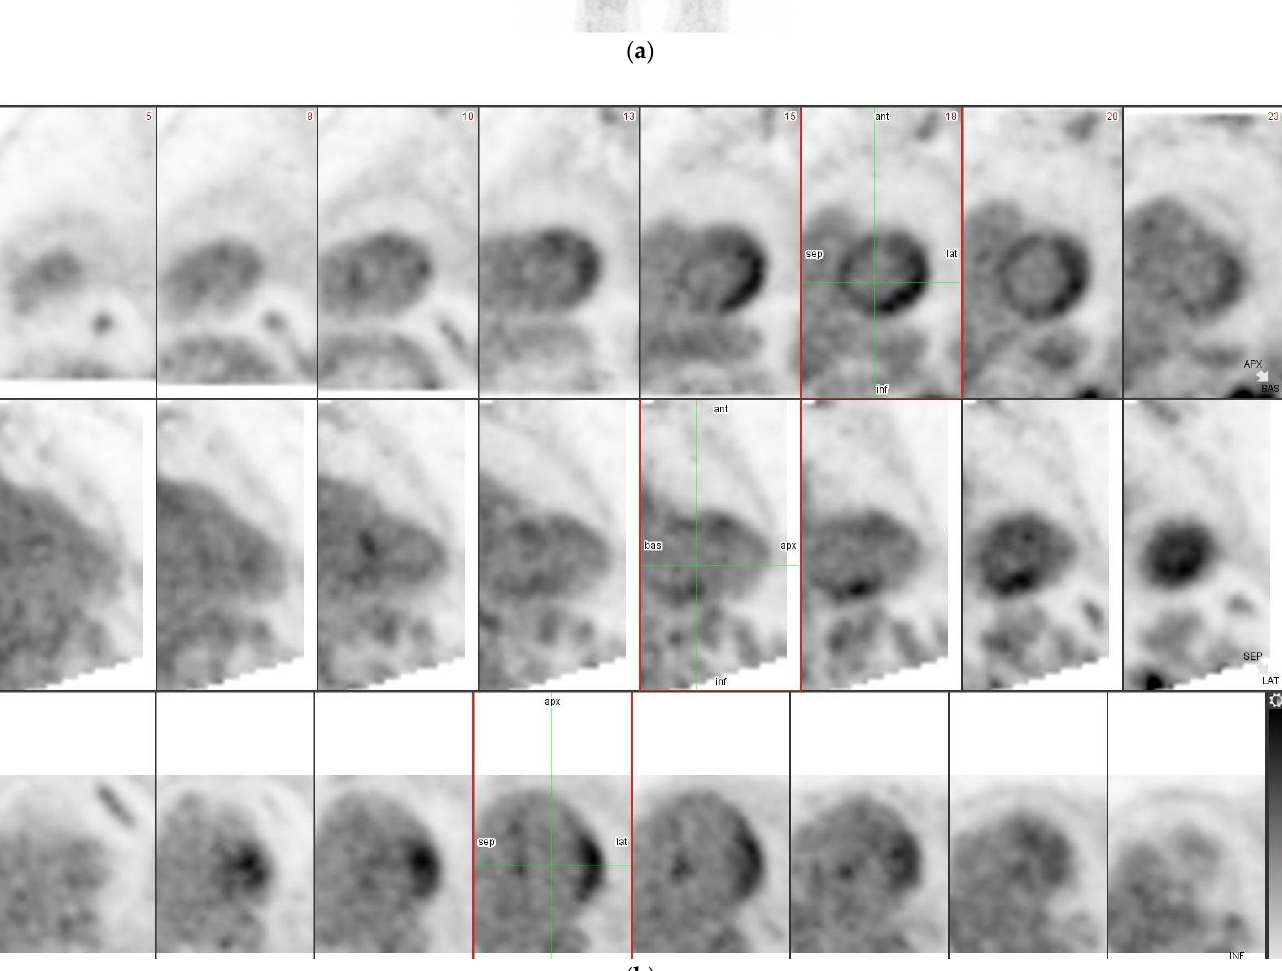
Figure 2. FDG PET scan. ( a ) Whole body MIP image. ( b ) The short, vertical and horizontal long axis images show 18 F-FDG uptake in the basal segments of the anterolateral, inferolateral and inferior wall and in the basal segment of the anteroseptal wall . Slice 10 mm, zoom × 1